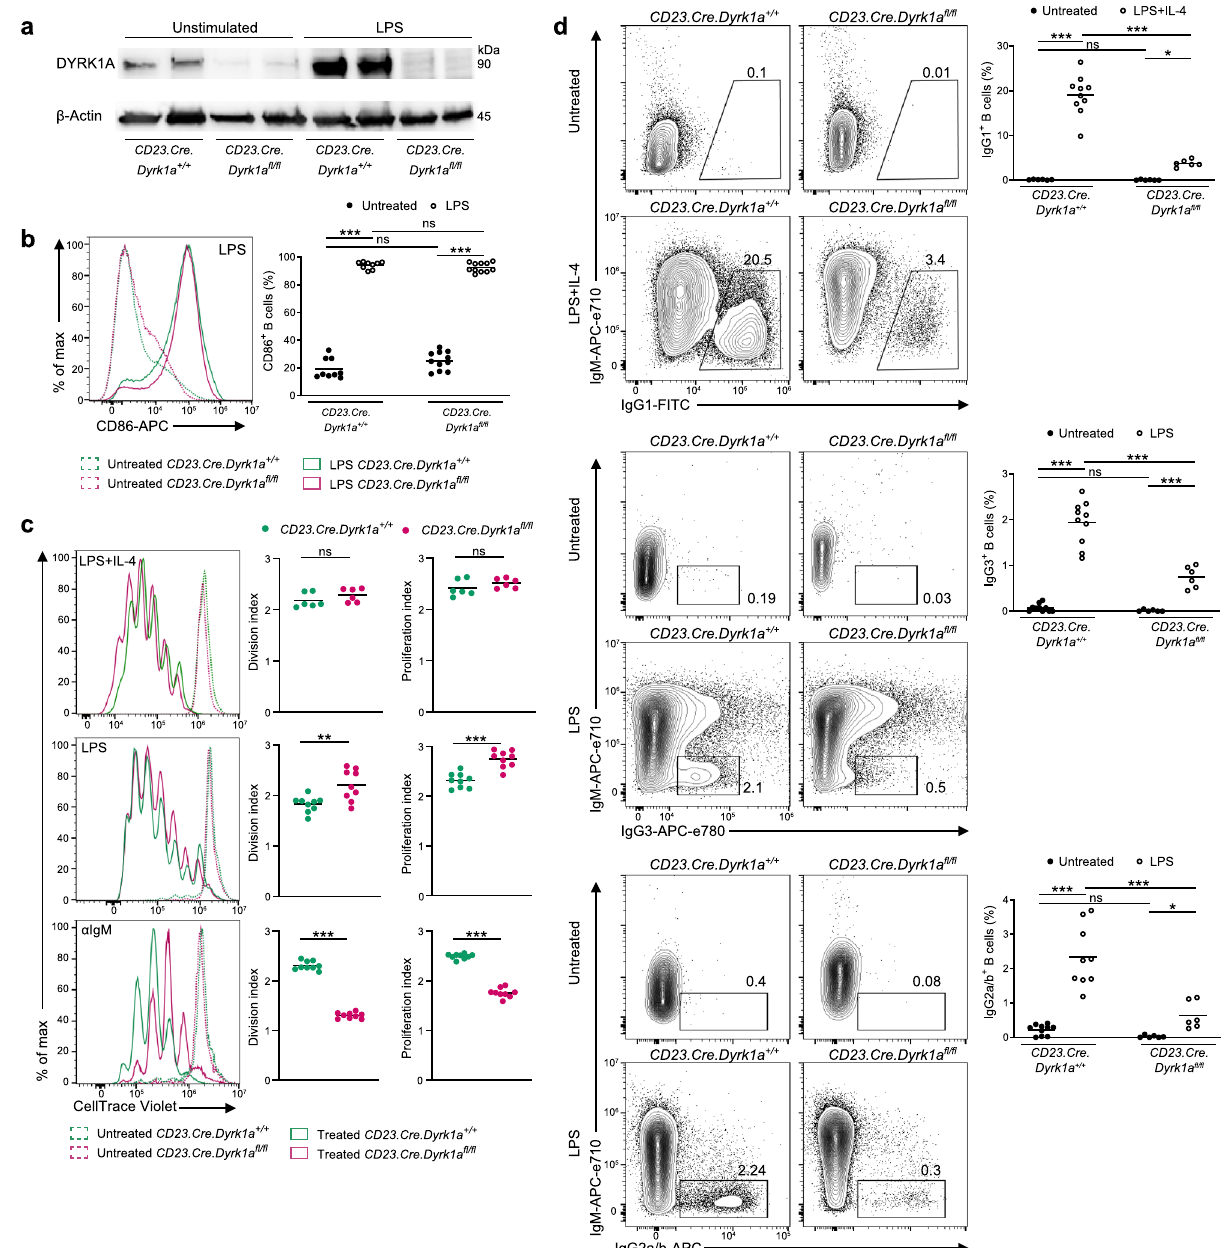
Fig. 1 | Class-switch recombination requires DYRK1A independently of B-cell proliferation. a DYRK1A protein expression was determined by western blot ana- lysisofBcellsthatwereeitherleftunmanipulatedorstimulatedwithLPSfor3days. Blots show two independent biological repeats. b Representative fl ow cytometry histograms and frequencies of activated B cells 16h after LPS stimulation in vitro ( n =9 – 11; three independent experiments, one-wayANOVA). c Representative fl ow cytometryhistogramsandquanti fi cationofCellTraceVioletdilutionsrepresenting